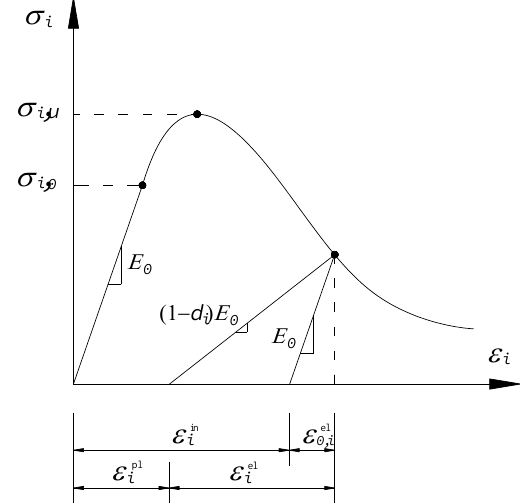
Figure 6. Constitutive relation of concrete.